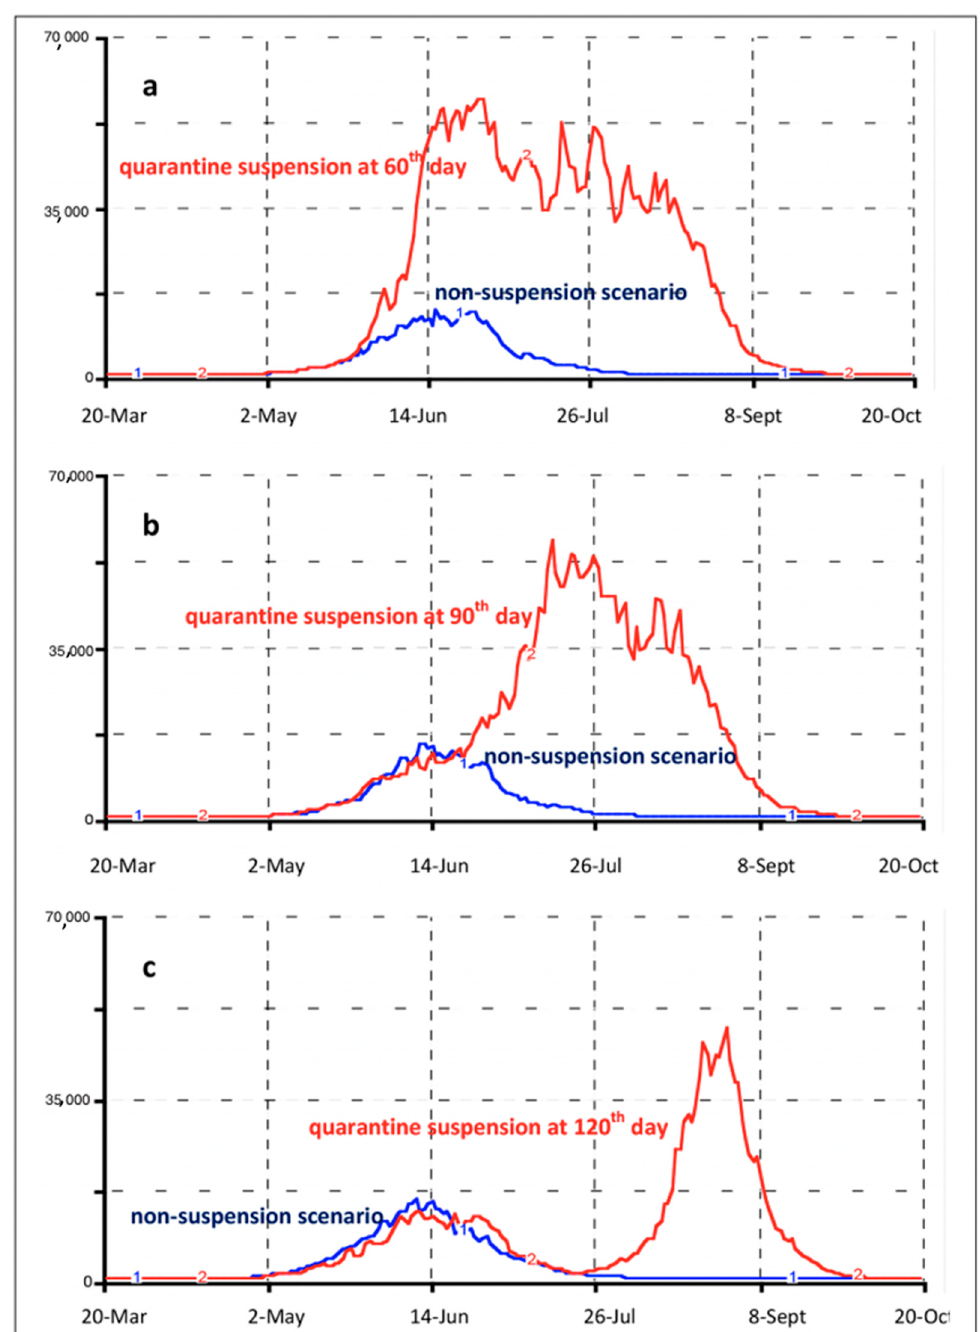
Figure 9. Graphics depicting the effects of interrupted quarantine in 60–90–120-day intervals in Buenos Aires using 40% of a quarantined population [33].